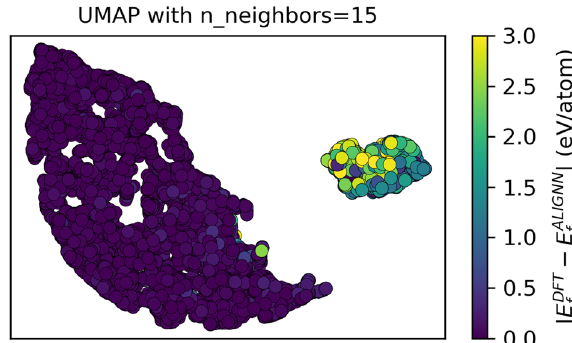
Fig. 8 UMAP projection of the AoI test data represented by the ML model disagreement. The disagreements between the ALIGNN and other models are used to represent the data